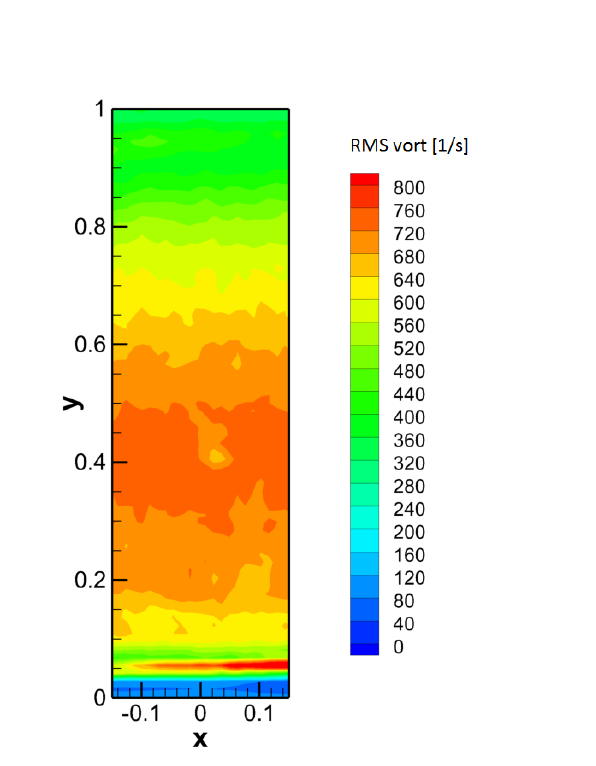
Fig. 8. Vorticity RMS distribution.